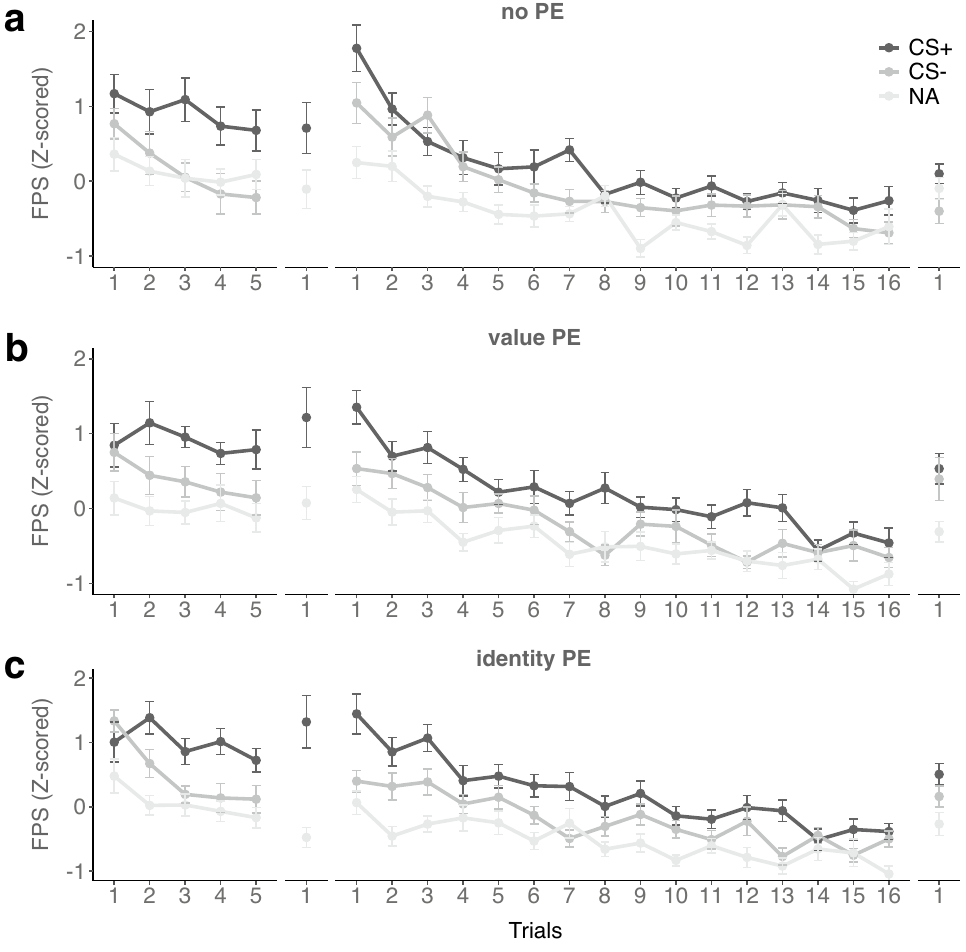
Figure 4. Startle responses during CS+ , CS− and noise alone (NA) trials across conditioning on day 1, fear memory reactivation on day 2, and retention (in extinction) and reinstatement test on day 3 in ( a ) the no-PE control group, ( b ) the value-PE group, and ( c ) the identity-PE group. Error bars depict standard errors of the